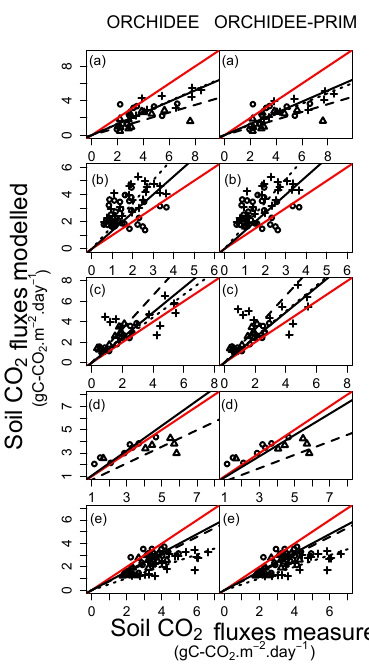
Figure 4. Soil CO 2 efflux calculated by ORCHIDEE on the left side and by ORCHIDEE–PRIM on the right side for the data coming from Boone et al. (1998) (a) , from Borken and Muhs (2002) (b) , from Chemidlin-Prévost-Bourré et al. (2010) (c) , from Subke et al. (2004) (d) , and from Sulzman et al. (2005) (e) . Red lines indicate the 1:1 line, black, dashed, and dotted lines correspond to control, litter exclusion, and litter amendment situations,